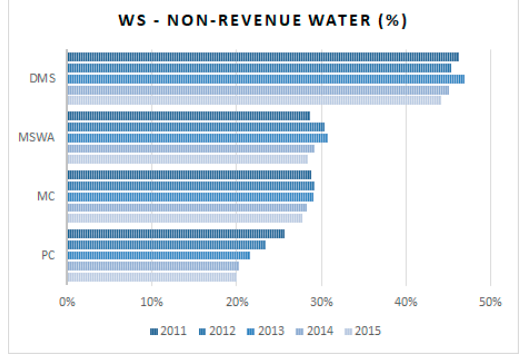
Figure 10. Evolution of non-revenue water.